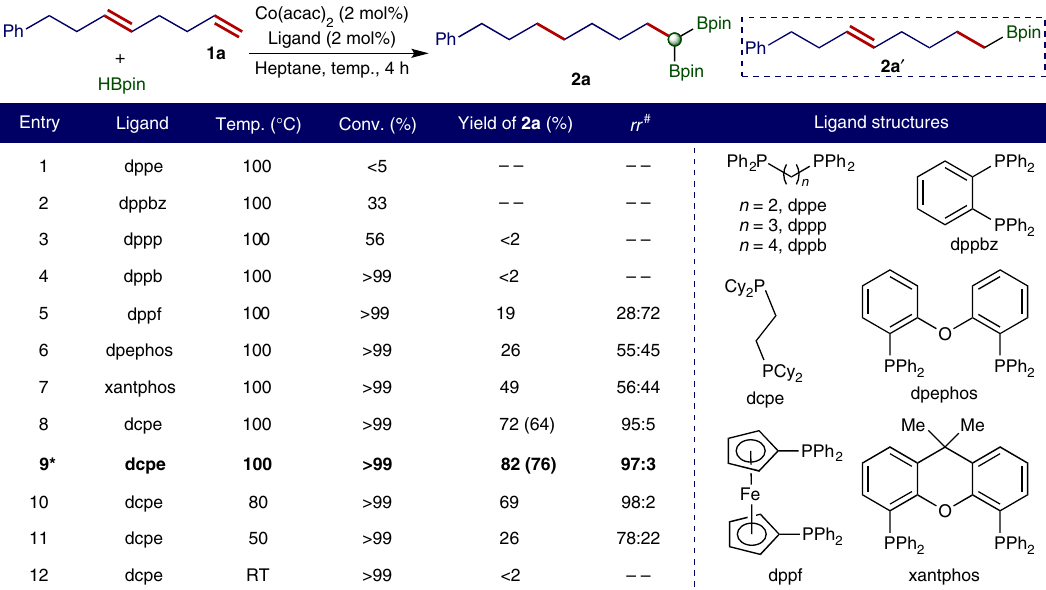
Fig. 2 Evaluation of conditions for cobalt-catalyzed double hydroboration of 1,5-diene 1a. Reaction conditions: 1a (0.200 mmol), HBpin (0.500 mmol), Co(acac) 2 (4.0 μ mol), ligand (4.0 μ mol), heptane (0.5 mL), 4 h, yield was determined by GC (gas chromatography) analysis using tridecane as internal standard and yield in parentheses was isolated yield of 2a . # rr is regioisomeric ratio and represents the ratio of the desired gem -bis(boryl)alkane product to the sum of all other bis(boryl)alkane isomers as determined by gas chromatography analysis.*3 mol % cobalt catalyst.